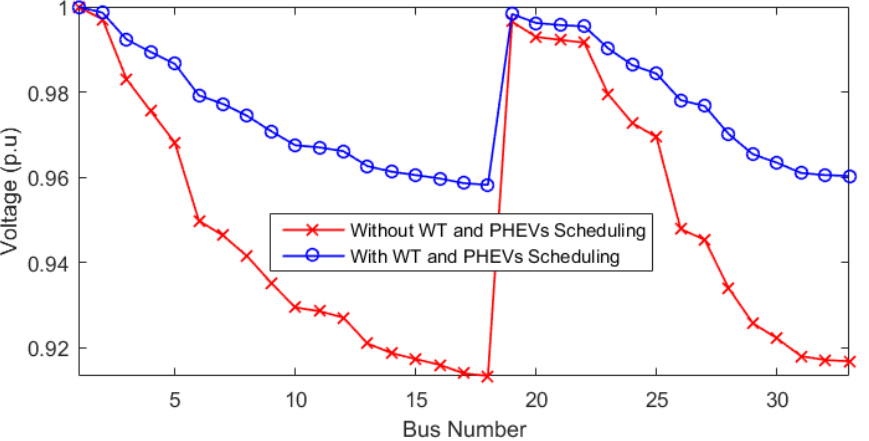
Figure 10. Voltage profile of a 33-bus distribution network with and without WT and PHEVs using the IGJO.